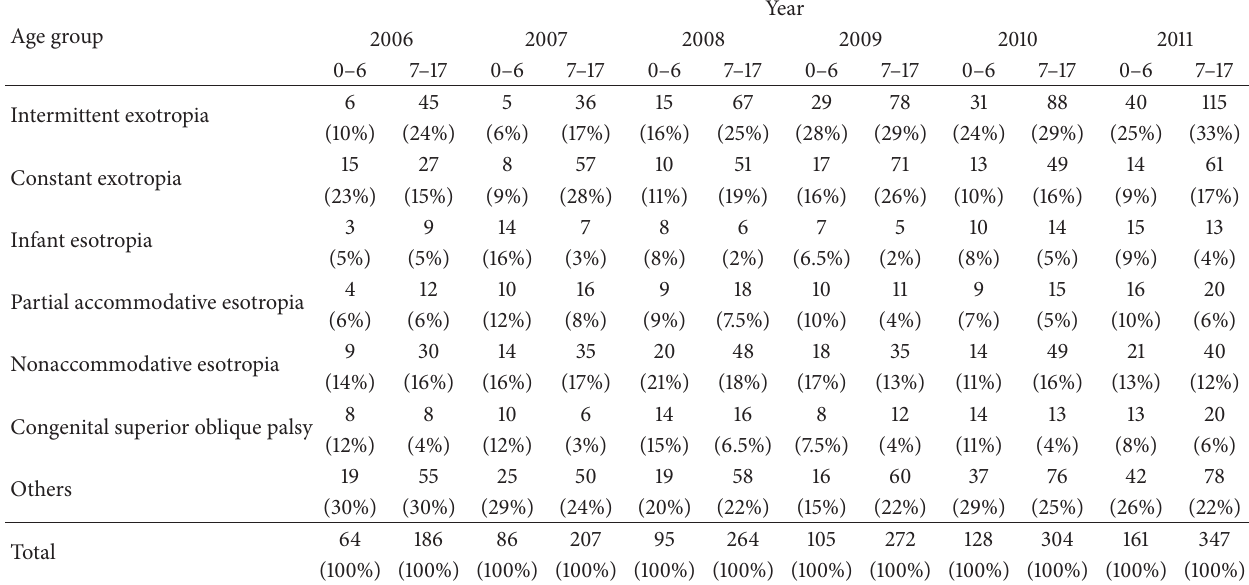
Table 1: Distributions of strabismus subtypes for all age groups between 2006 and